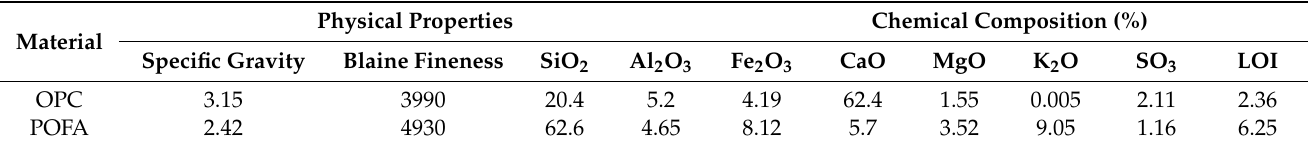
Table 1. Physical properties and chemical composition of the OPC and POFA.